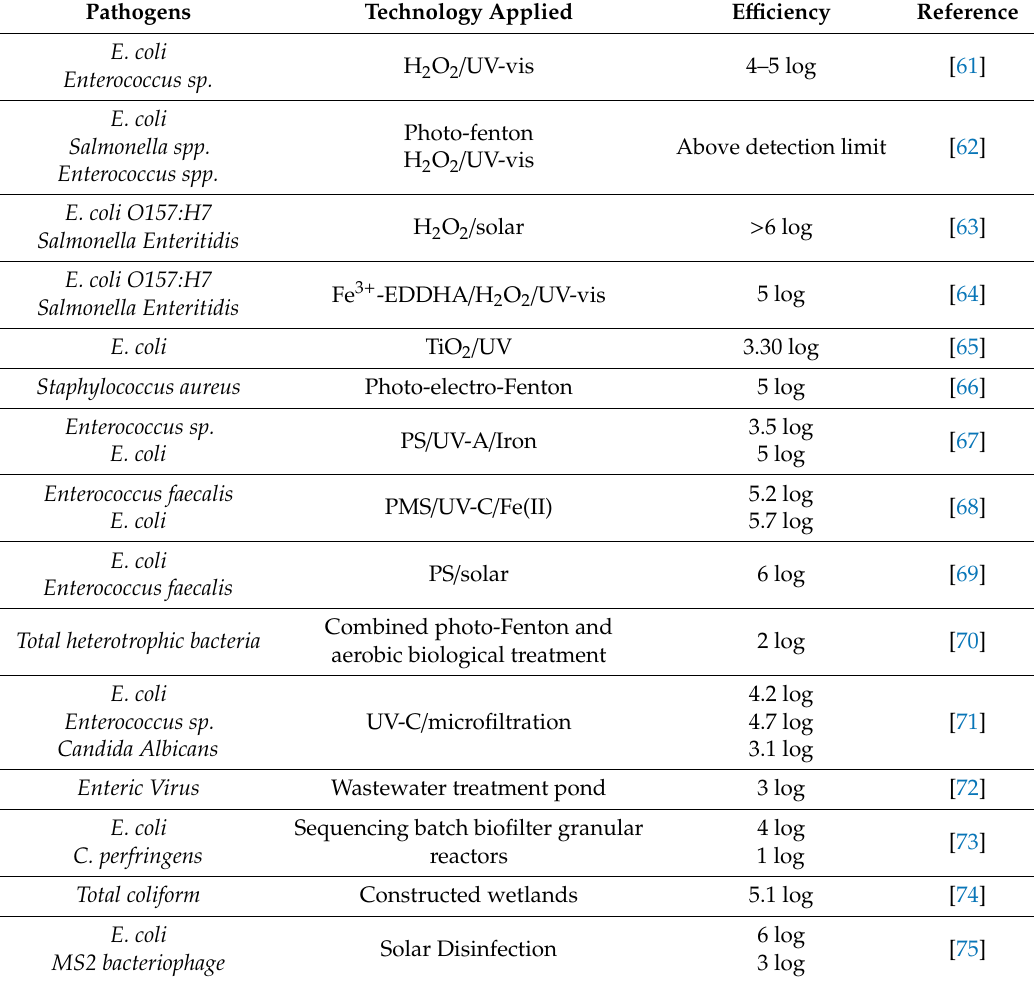
Table 2. Recent studies on the detection and / or removal of pathogens in treated e ffl uents.